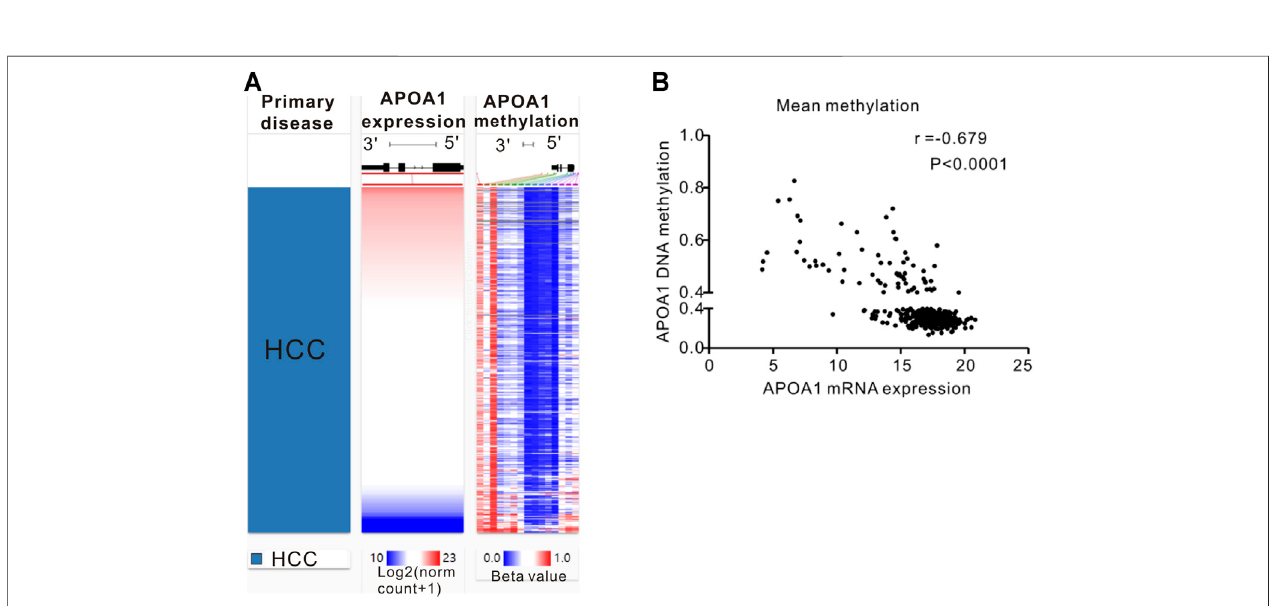
FIGURE 4 | The epigenetic mechanism underlying aberrant expression of APOA-1 in HCC revealed by bioinformatic analysis. (A) Heatmap of the association between expression of APOA-1 mRNA and the methylation of APOA-1 DNA CpG sites; (B) a negative correlation is observed between APOA-1 mRNA and APOA-1 DNA